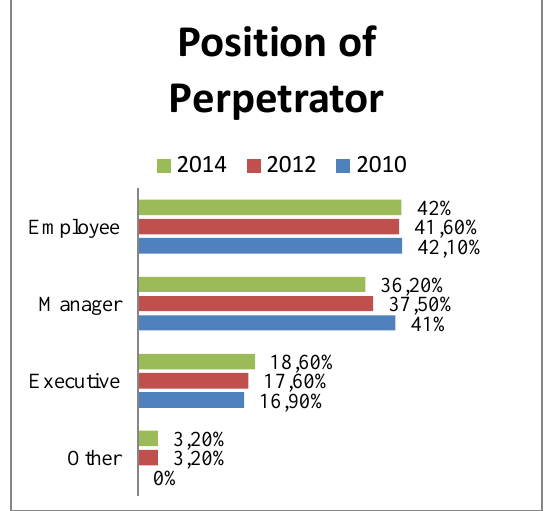
Figure 4. Position of Perpetrator